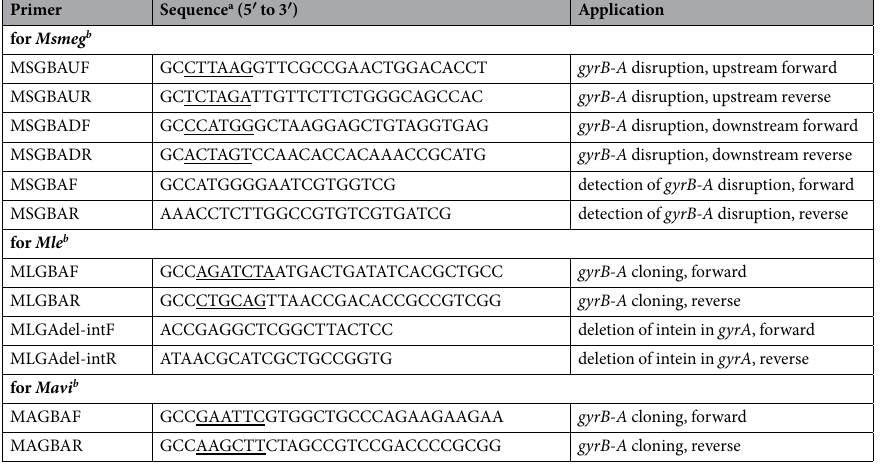
Table 1. Primers used for this study. a Restriction endonuclease cleavage site are underlined. b Msmeg , Mle , and Mavi means M . smegmatis, M . leprae , and M . avium ,